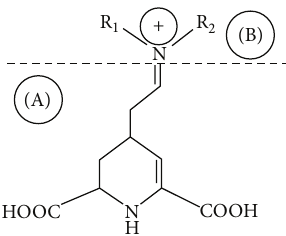
Figure 5: Betalains general formulae. (A) Betalamic acid moiety is present in all betalain molecules. (B) The structure will represent a betacyanin or a betaxanthin, depending on the identity of the R 1 and R 2 residues (adapted from